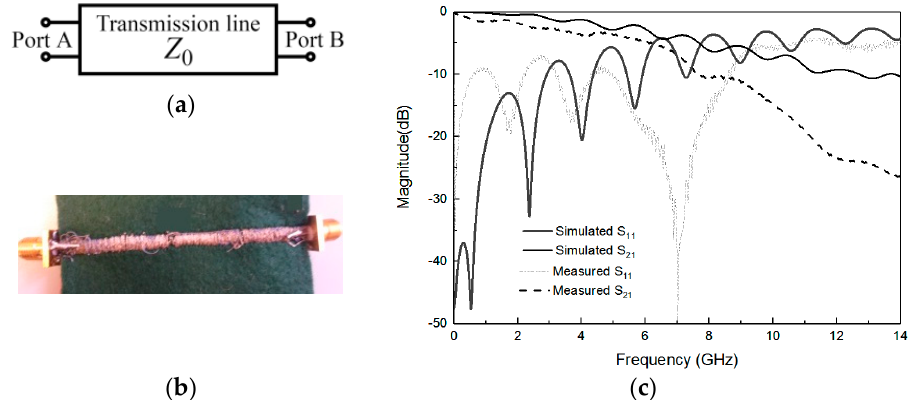
Figure 1. ( a ) The circuit representation of the stitched transmission line. ( b ) Photograph of the embroidered design. ( c ) Simulated and measured S-Parameters of stitched transmission line.